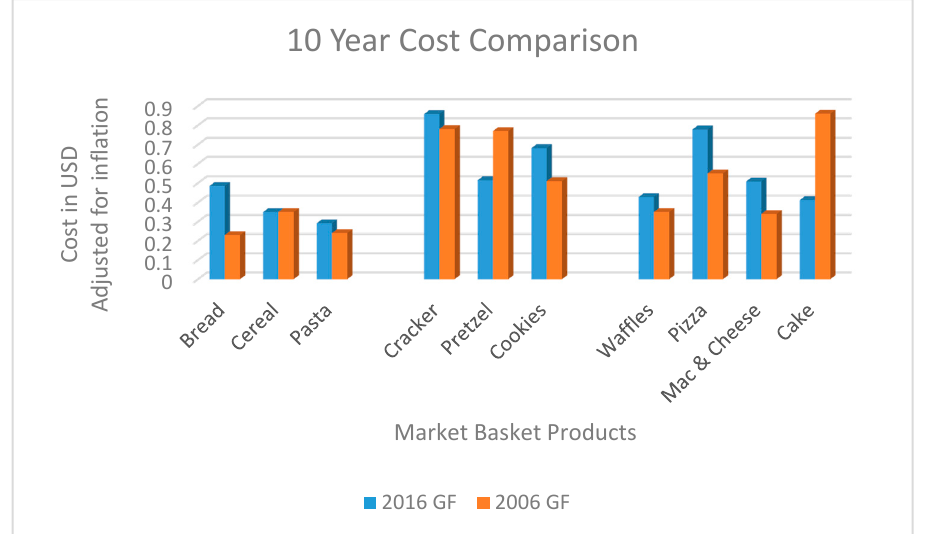
Figure 2. Cost comparison of GF products from 2006 to 2016 by market basket category in price per ounce adjusted for inflation.